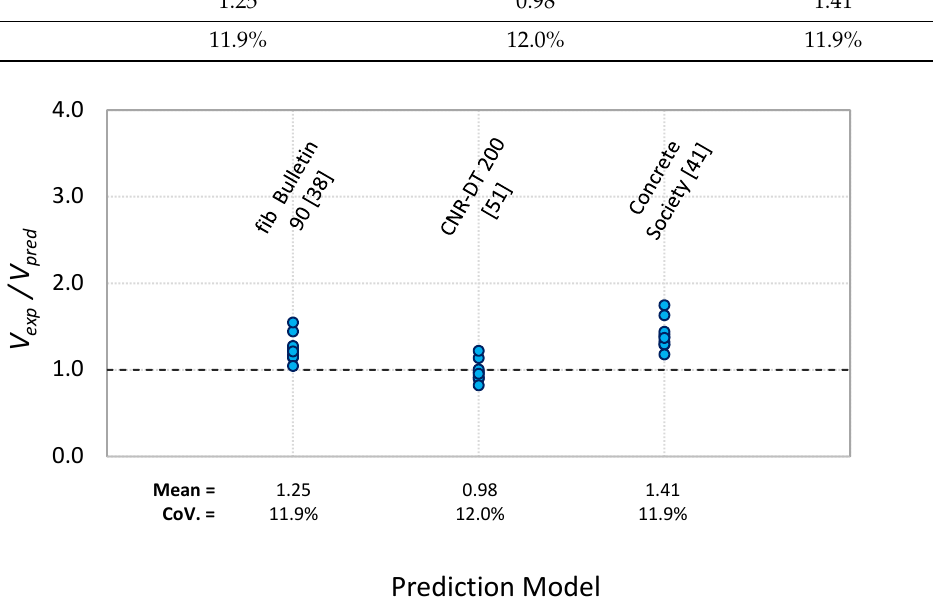
Figure 11. Comparison of experimental and predicted plate end debonding capacity using shear- based models.